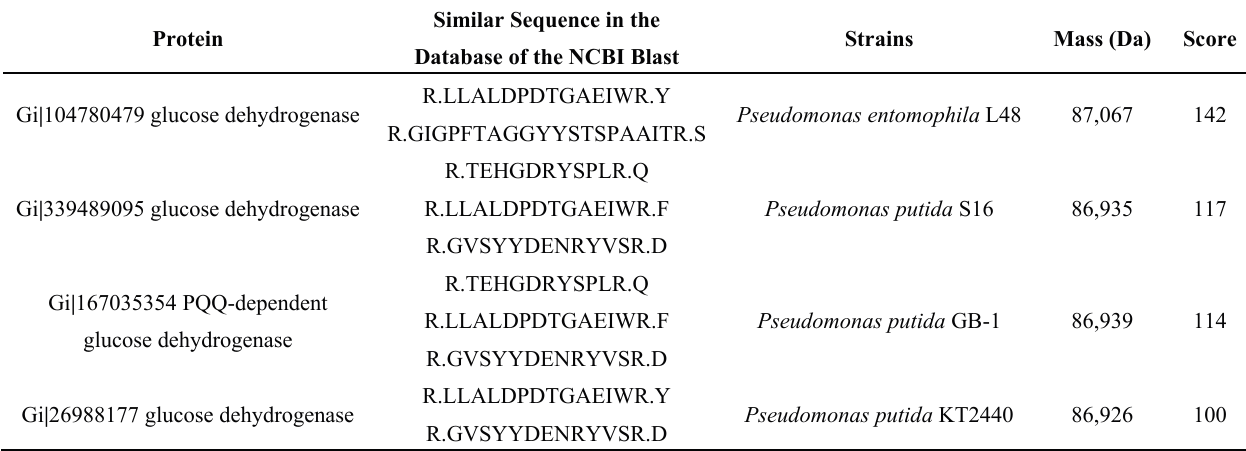
Table 2. Database search results of GlcDH from A. globiformis